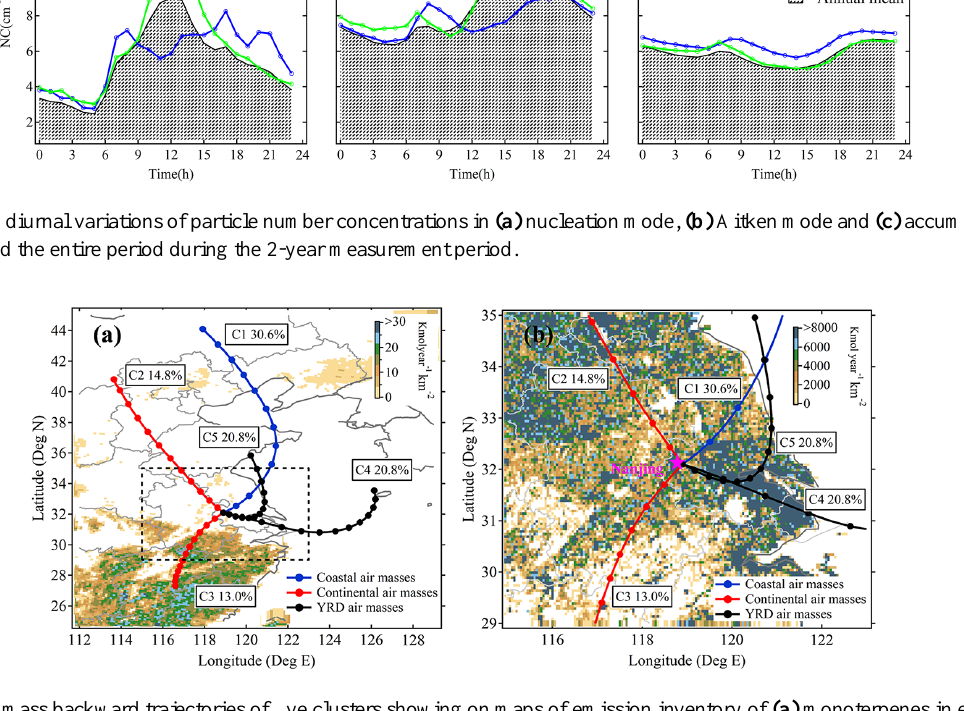
Figure 6. Mean air mass backward trajectories of five clusters showing on maps of emission inventory of (a) monoterpenes in eastern China and (b) anthropogenic VOCs in the YRD. Note: points of trajectories represent the 6-hourly location. The percentages of each cluster are tabulated in the map. The monoterpene data were calculated by MEGAN (Model of Emissions of Gases and Aerosols from Nature) with MM5 (the Fifth-Generation Mesoscale Model) providing meteorological data and the anthropogenic VOC data were accessed from the MEIC (Multi-resolution Emission Inventory for China) database